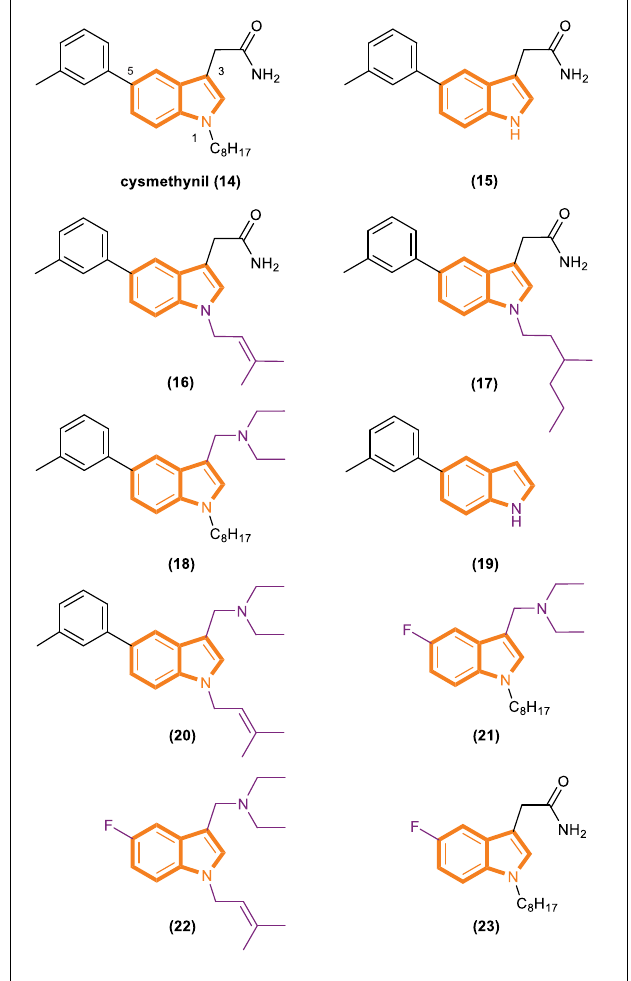
FIGURE 4 | Cysmethynil and its analogs